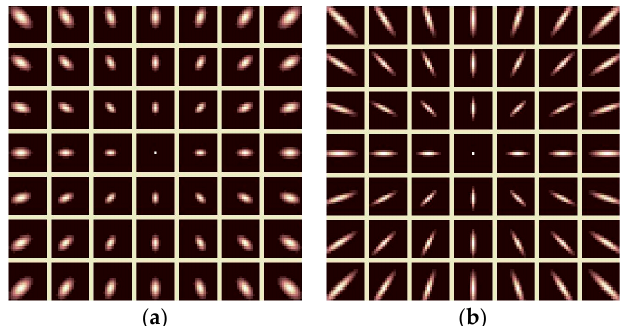
Figure 2. Anisotropic foveation operators with a 7 × 7 foveated patch and θ = 0. ( a ) ρ = 2; and, ( b ) ρ =